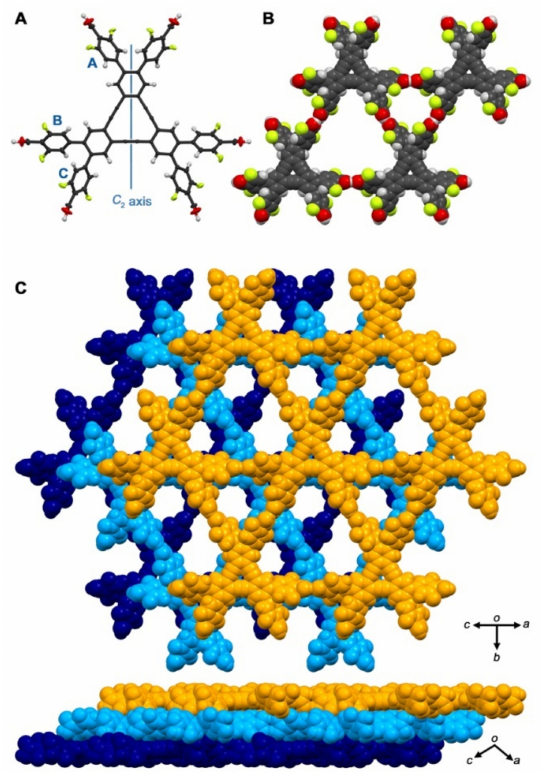
Figure 2. Crystal structure of hydrogen-bonded organic framework (HOF) <T12F-1(124TCB). ( A ) C 2 - symmetric molecular structure drawn by anisotropic displacement ellipsoid plot with 50% probability. ( B ) Packing motif of the framework with two kinds of different pores. ( C ) Selected layered structure of the